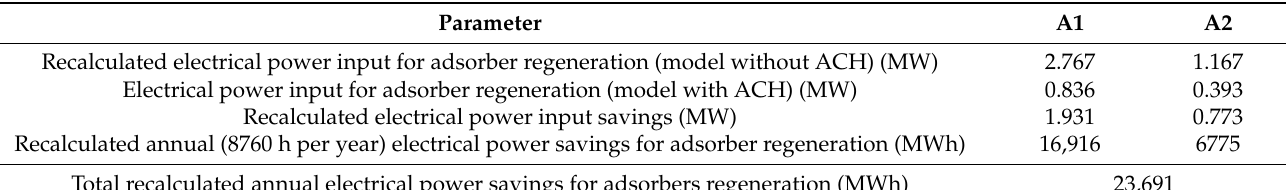
Table 13. Recalculated power input savings in model with ACH compared to basic model (without ACH). Parameter A1